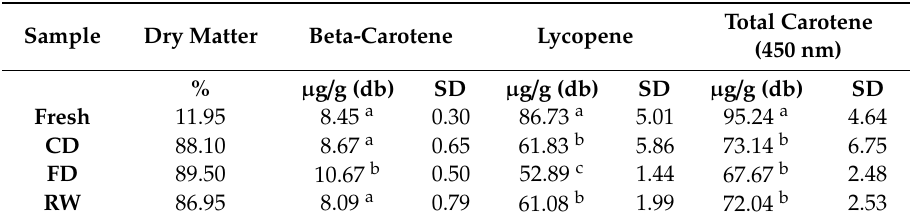
Table 2. Carotene content in guava pulp dried by the CD, FD and RW methods. Di ff erent letters indicate significantly di ff erence between di ff erent treatments ( p <